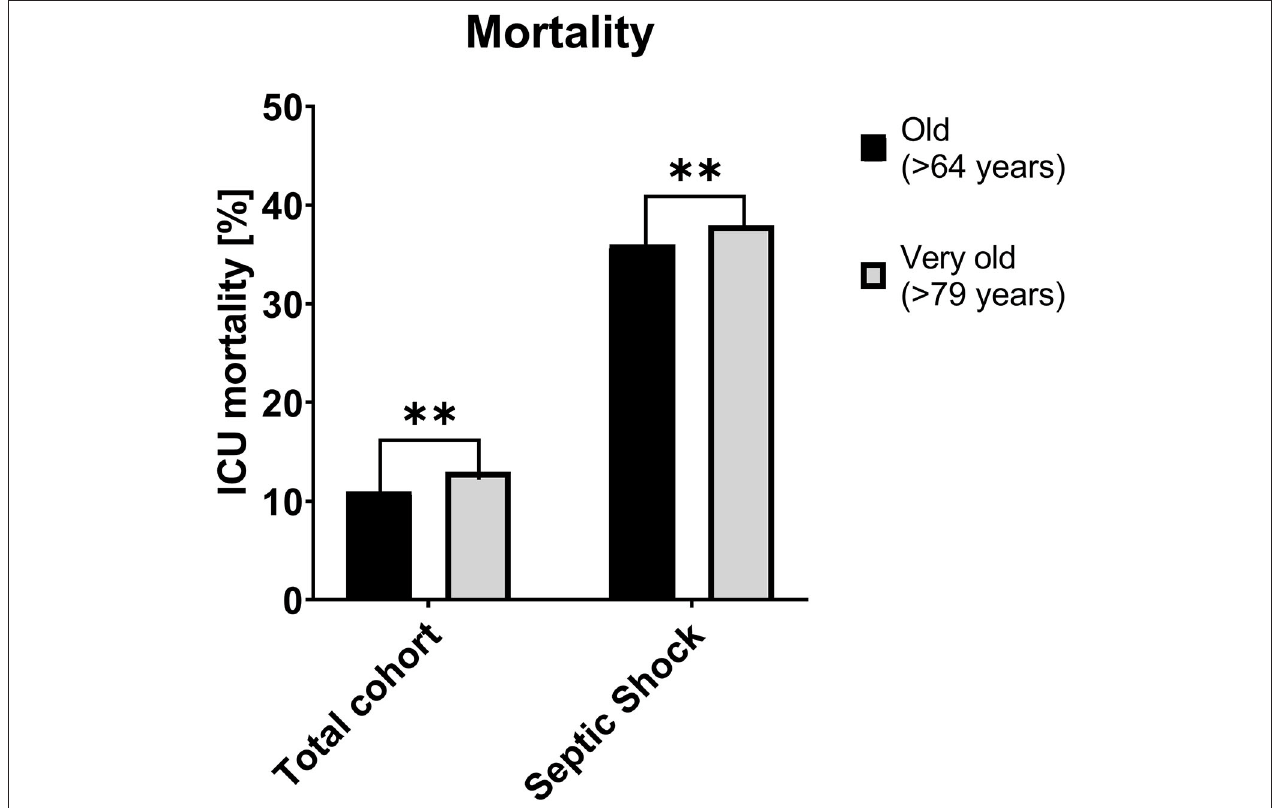
FIGURE 1 | ICU-Mortality of the total cohort (left) and the subgroup for patients with septic shock (right) , [%] ** p < 0.01. ICU, Intensive care unit.